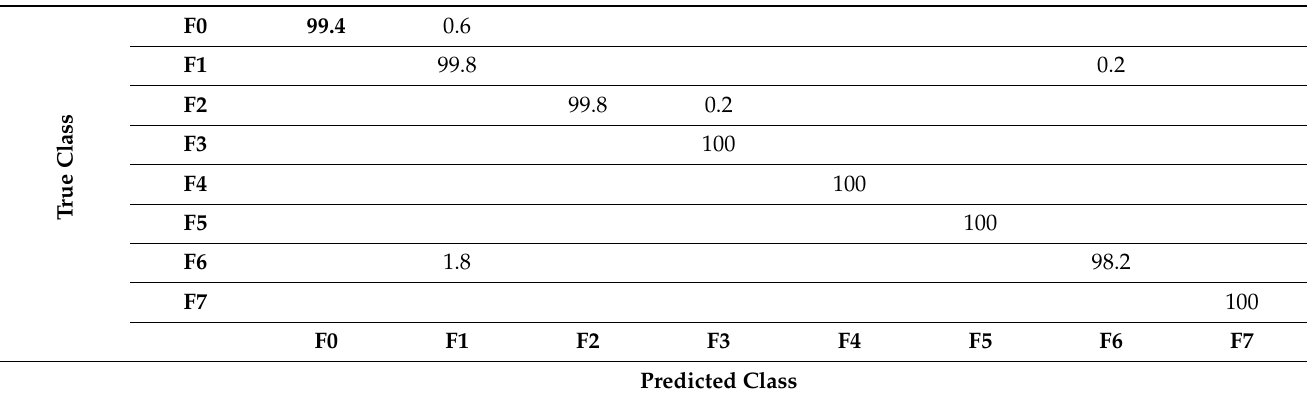
Table 4. Confusion matrix for LWSN for Sallen–Key bandpass filter.